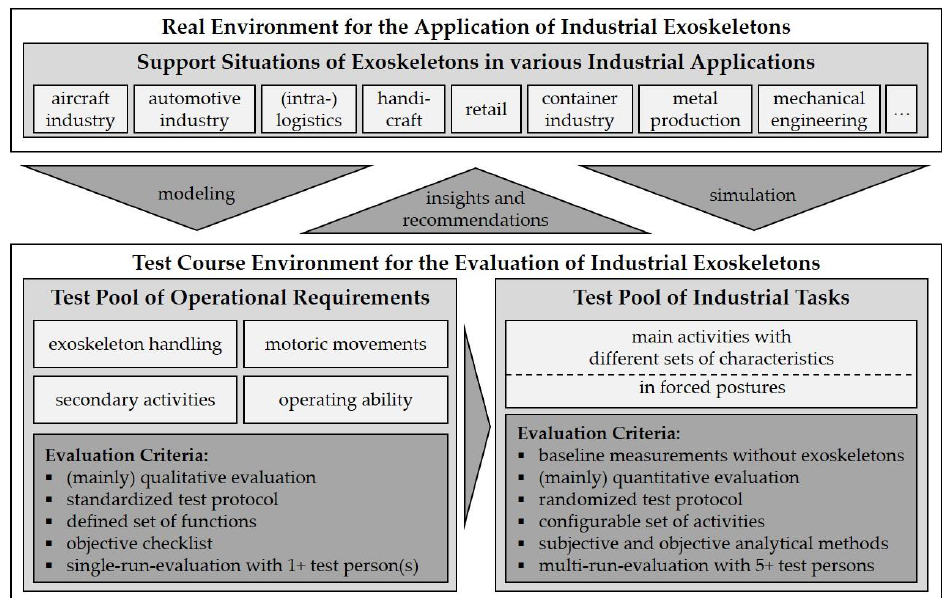
Figure 2. Interrelation between real application scenarios and test course environment.